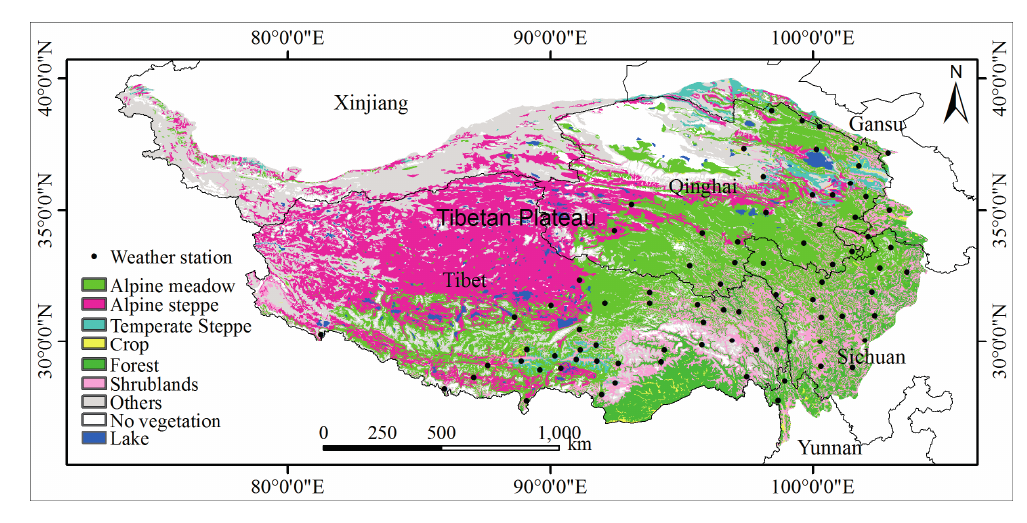
Figure 1. Types of vegetation and the location of meteorological stations on the Tibetan